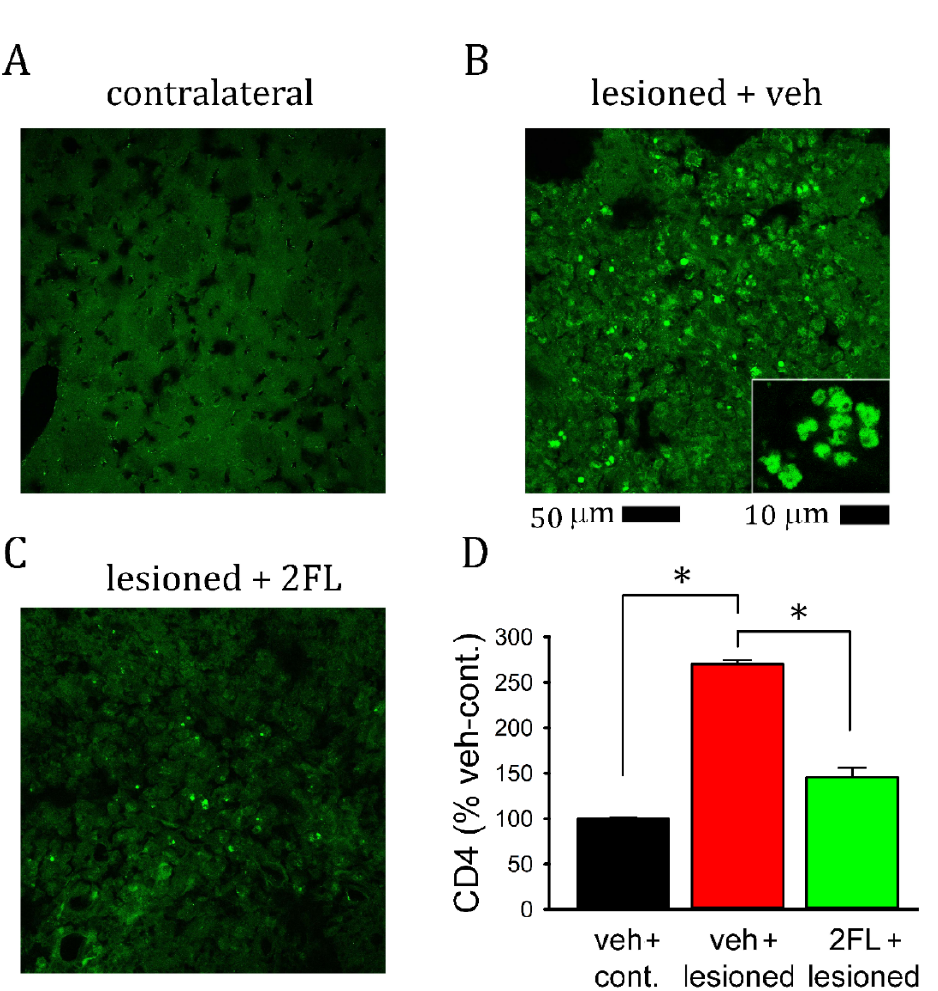
Figure 4. Post-treatment with 2FL reduced CD4 + lymphocyte infiltration into the lesioned brain. Representative photomicrographs demonstrate the CD4 immunoreactivity in ( A ) the non-lesioned striatum and ( B ) the lesioned striatum from a rat receiving vehicle at low (calibration = 50 µ m) and high magnification (insert, calibration = 10 µ m), as well as ( C ) the lesioned striatum from a rat receiving 2FL. ( D ) 2FL significantly reduced CD4-ir in the lesioned brain (* p < 0.001, one-way ANOVA).